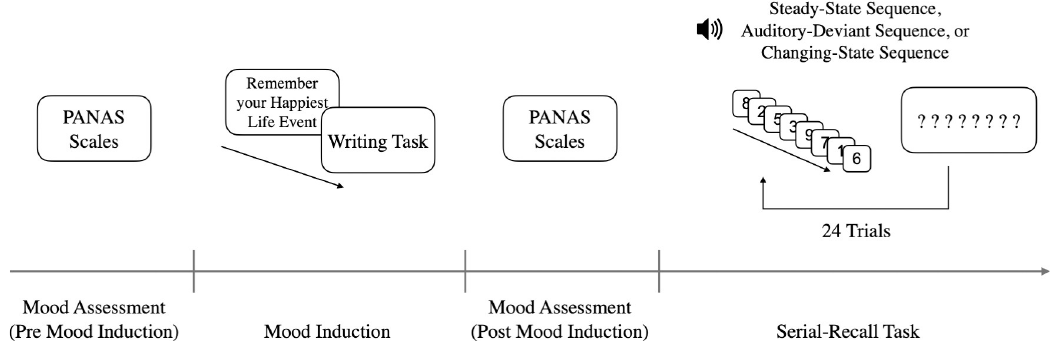
Fig 1. Schematic illustration of the experimental procedure of Experiment 1 following the serial-recall training trials. The happy mood-induction procedure is illustrated.